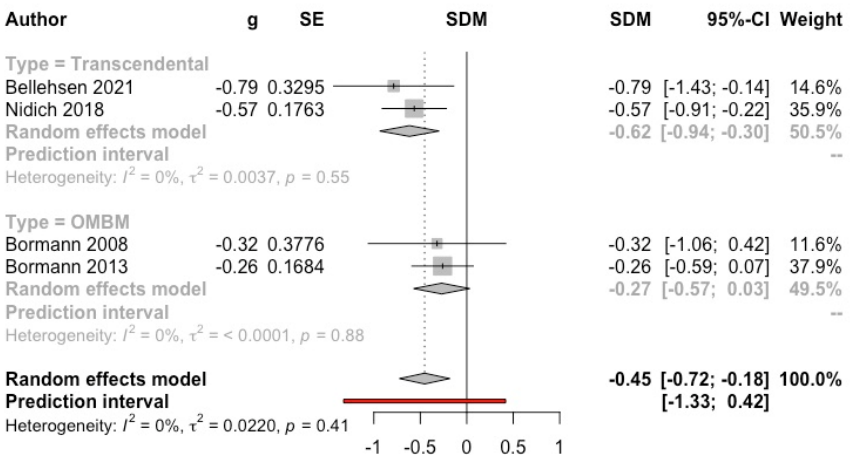
Figure 8. Effect on post-traumatic stress disorder symptoms (clinician-reported) (meditation vs. control). Predictive intervals are represented in red.